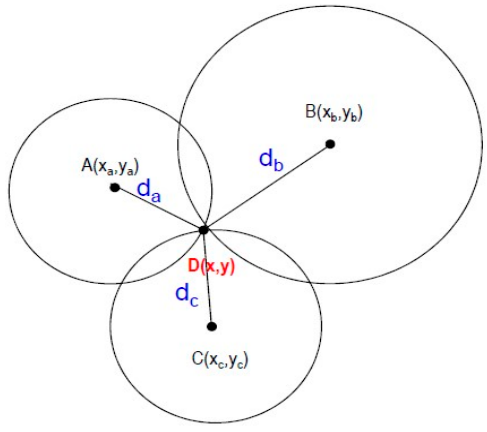
Figure 2. Trilateral measurement method.